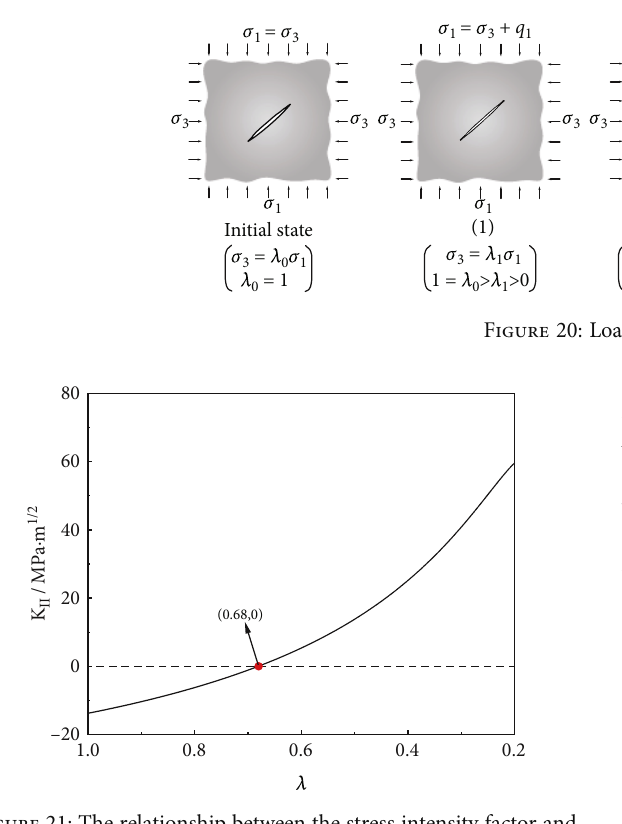
Figure 21: The relationship between the stress intensity factor and con fi ning pressure coe ffi cient for μ = 0 : 3